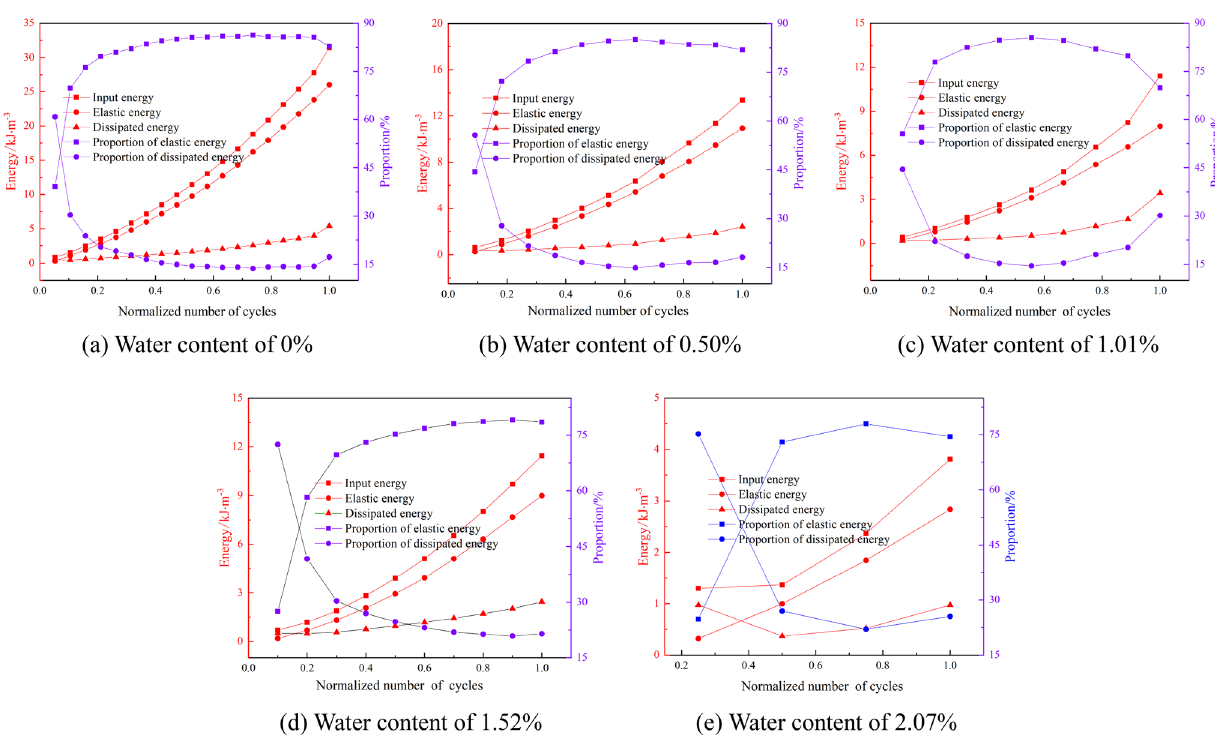
Fig. 10 Energy distribution diagram